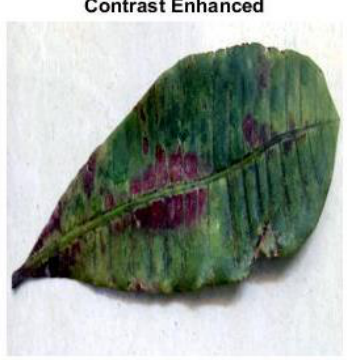
Figure 4. Contrast enhanced image of the input